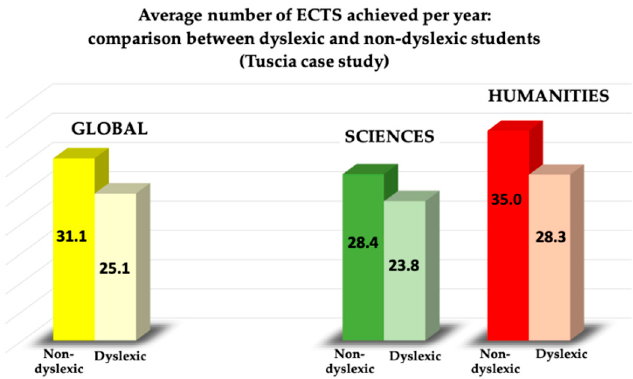
Figure 5. Average number of ECTS achieved per year: comparison between dyslexic and non-dyslexic students globally and specifically for sciences and humanities, according to the Tuscia case study.